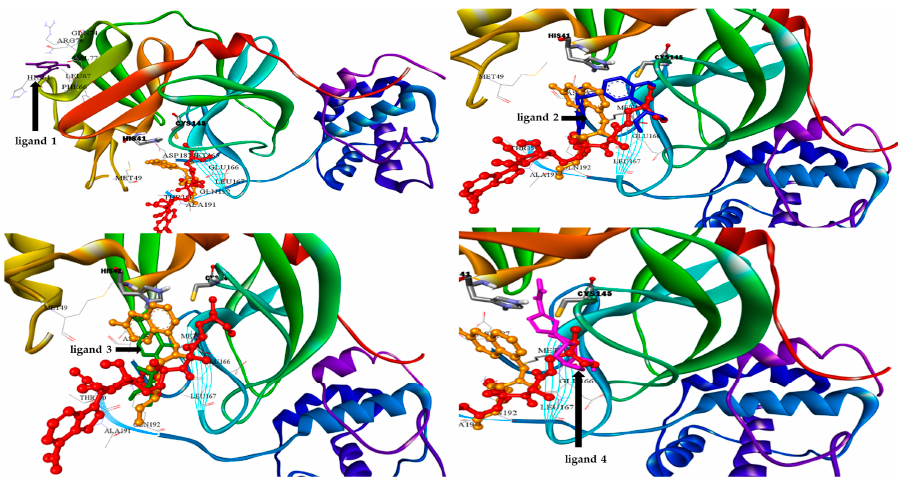
Figure 4. 3D docking models of SARS-CoV-2 M pro complexes showing superimposition of the ligand 1 (violet stick), ligand 2 (blue stick), ligand 3 (green stick), ligand 4 (pink stick) with hydroxychloroquine (orange stick and balls) and remdesivir (red stick and balls) in the protein pocket, the amino acids of the catalytic dyad (gray stick).